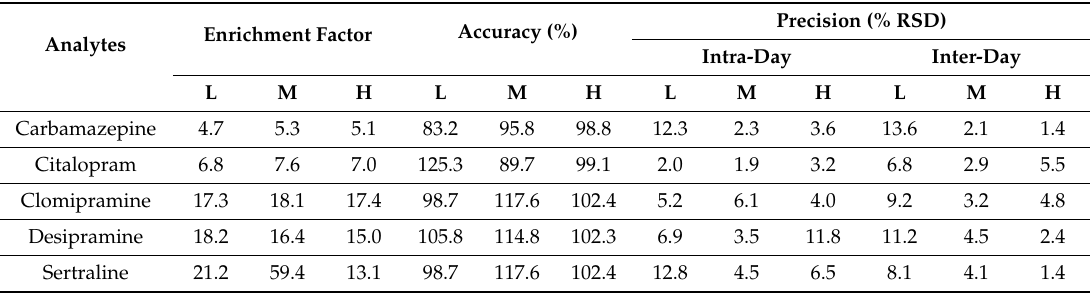
Figure 3. Chromatograms obtained by comparing a 100 µg L − 1 spiked urine sample with an unspiked blank one in order to verify the selectivity of the proposed analytical method. Table 1. Method linearity characteristics and its limits of detection (LOD) and quantification (LOQ). Table 2. Additional figures of merit including the method enrichment factor, accuracy, and precision. RSD: Relative Standard